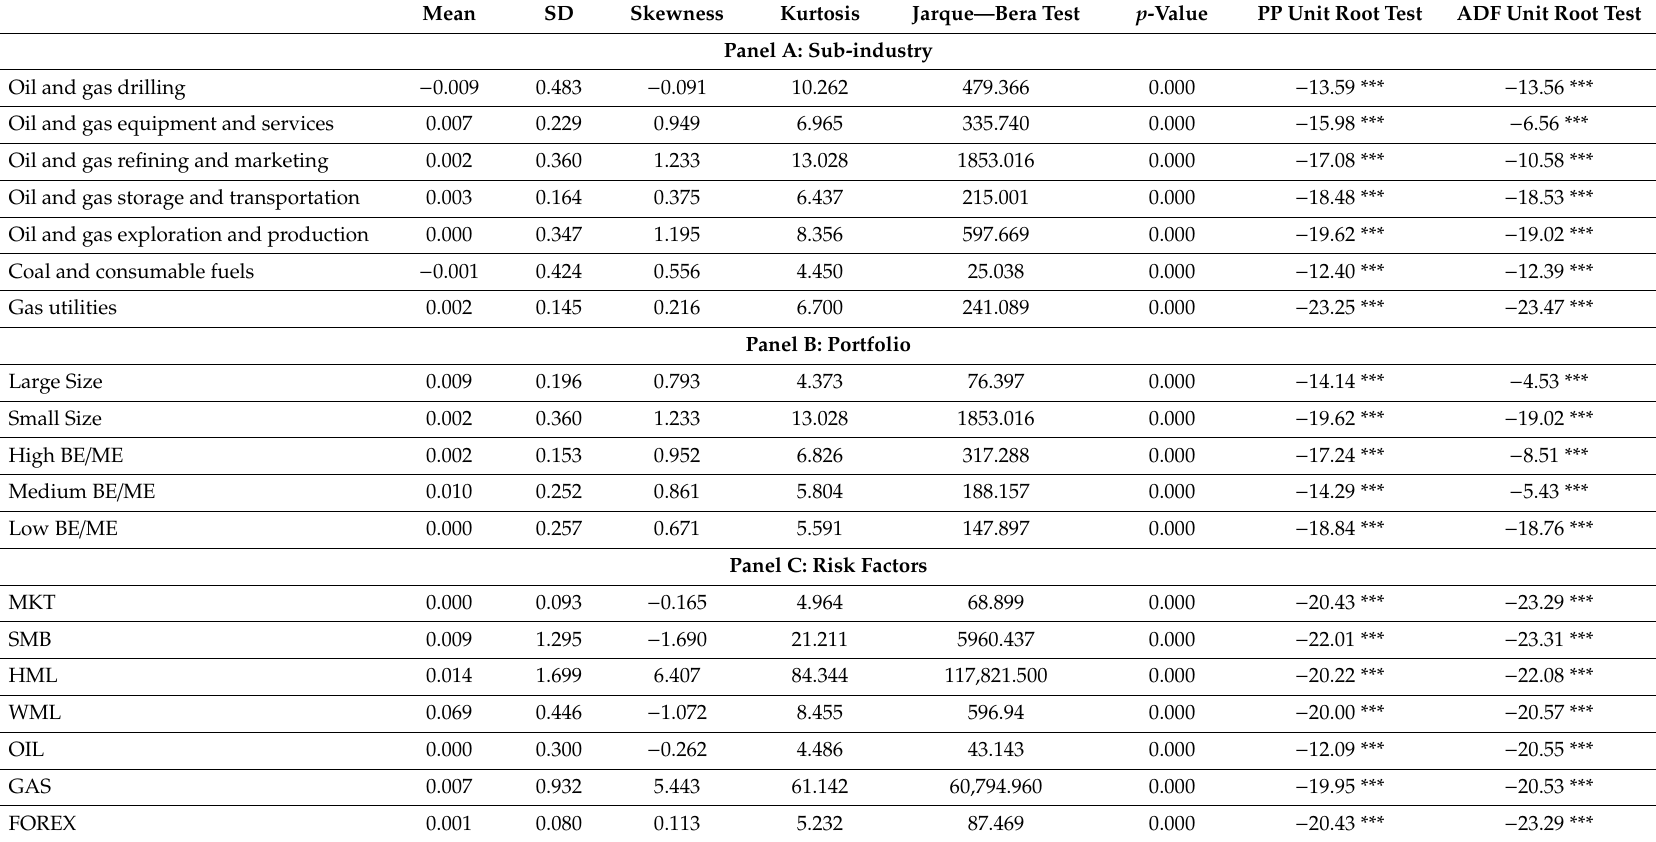
Table 1. Descriptive statistics and